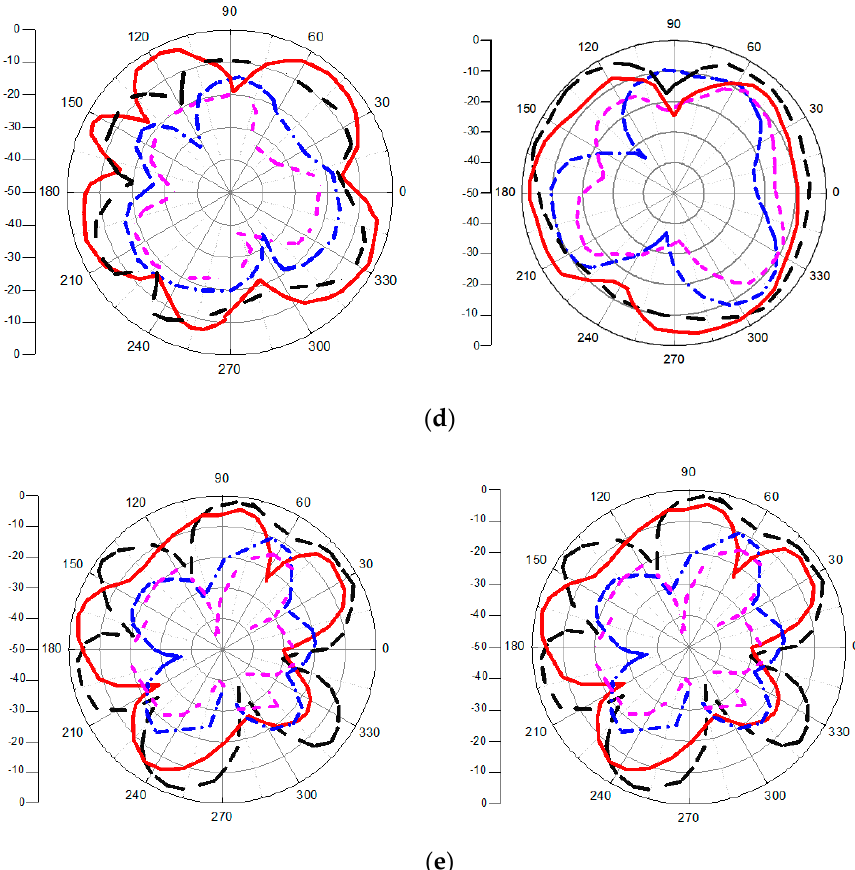
Figure 13. Simulated and measured response of co- and cross-polar radiation of the MIMO antenna on port 1 at the frequencies ( a ) 3.5 GHz, ( b ) 8 GHz, ( c ) 12 GHz, ( d ) 16 GHz, and ( e ) 21 GHz. Table 2. Comparison of the proposed MIMO antenna with other reported antennas.